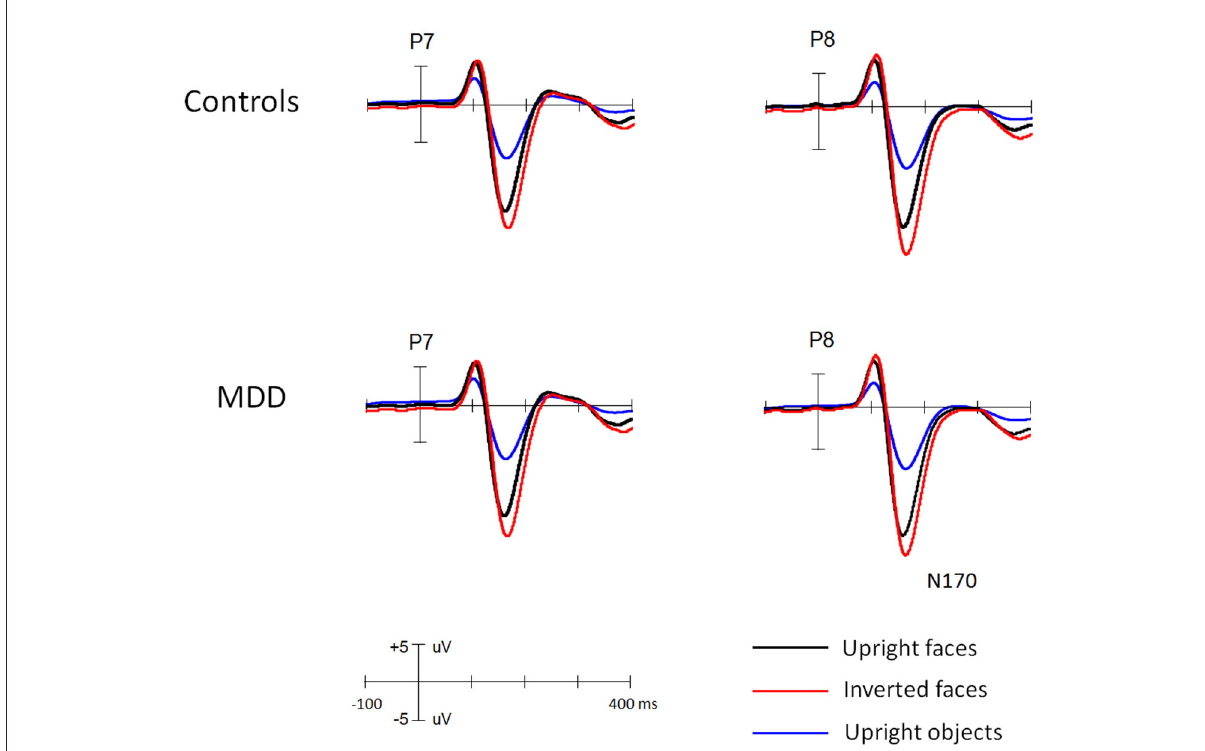
FIGURE1 The grand ERP waveforms elicited by faces and objects in young MDD patients and controls, respectively.